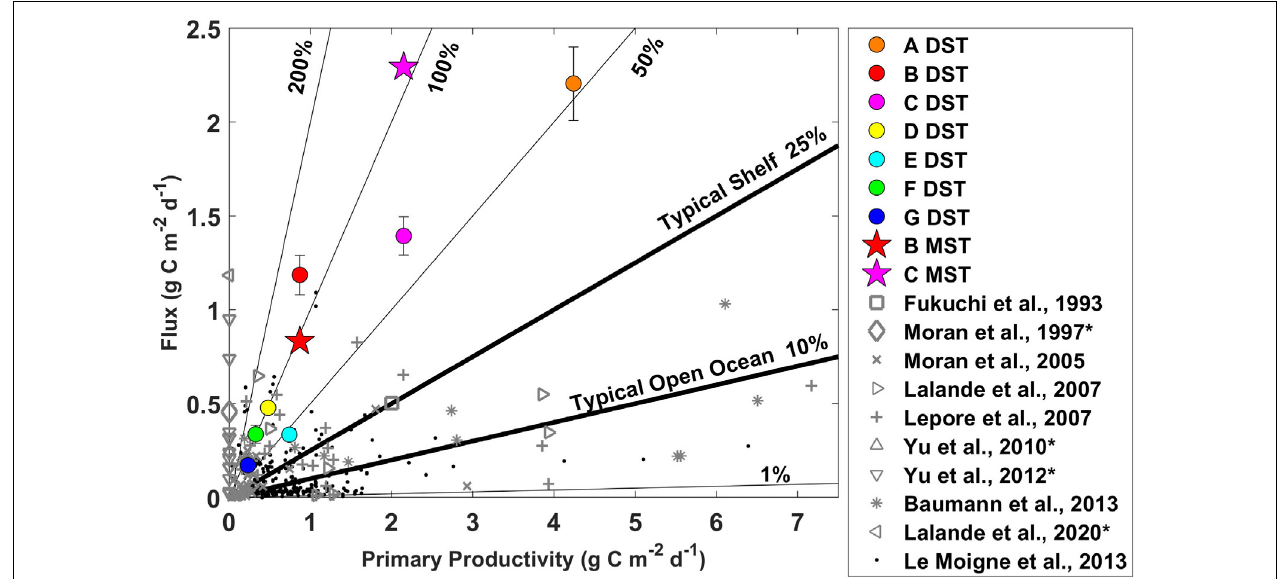
FIGURE 4 | Sinking particulate organic carbon fluxes and primary productivity rates with contours of the export ratio between these two parameters measured during June 2018 on the Pacific Arctic shelf. The circles represent flux measurements from the drifting sediment trap. The stars represent the final flux measurement from the moored sediment traps (values plotted against the same primary productivity rates). Gray markers provide regional (Fukuchi et al., 1993; Moran et al., 1997, 2005; Lalande et al., 2007, 2020; Lepore et al., 2007; Yu et al., 2010, 2012; Baumann et al., 2013) and black markers global context (Le Moigne et al., 2013). *No corresponding productivity data with Moran et al., 1997 (Moran et al., 1997), Yu et al. (2010, 2012), and Lalande et al., 2020 (Lalande et al.,